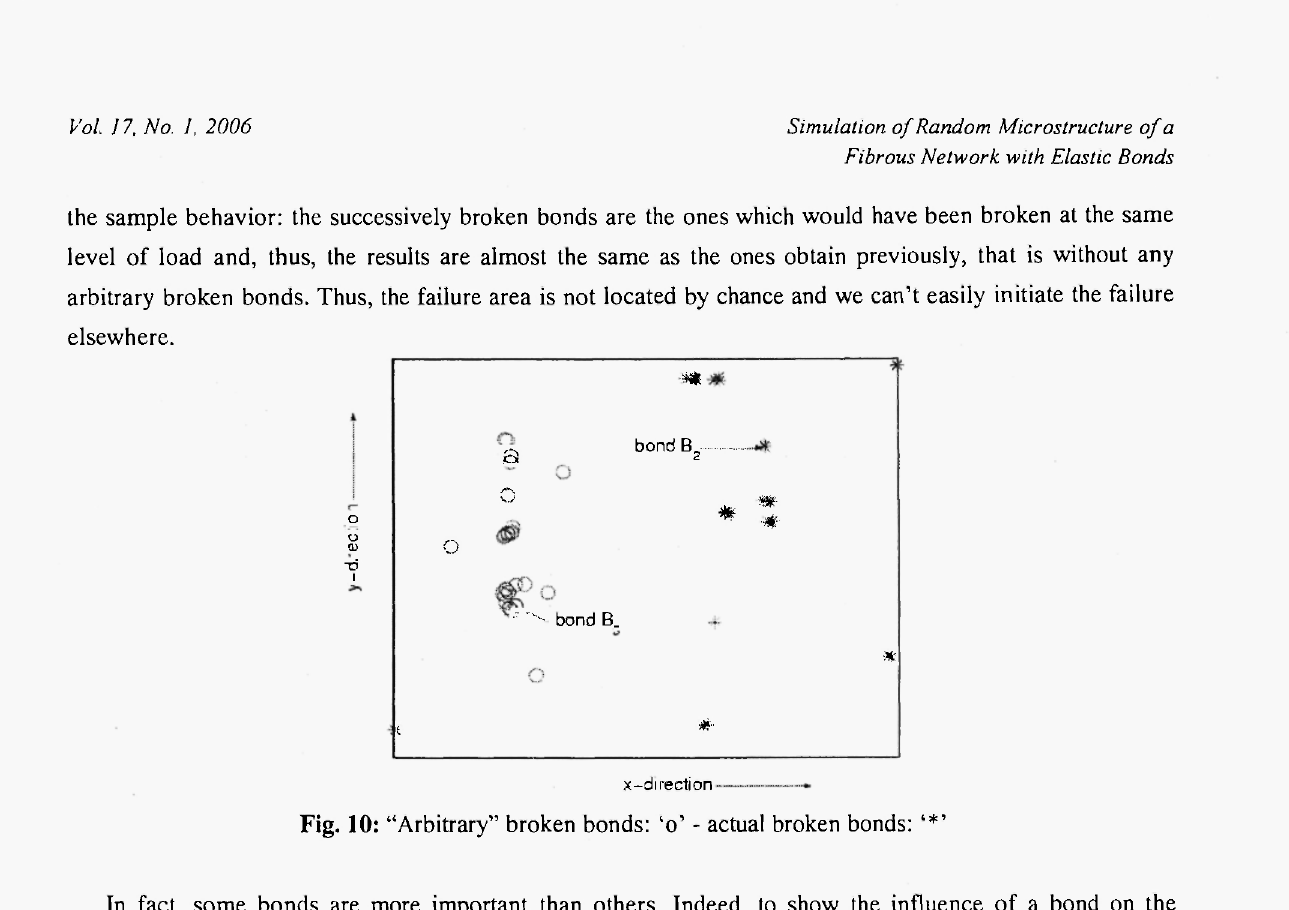
Fig. 10: "Arbitrary" broken bonds: 'ο' - actual broken bonds: